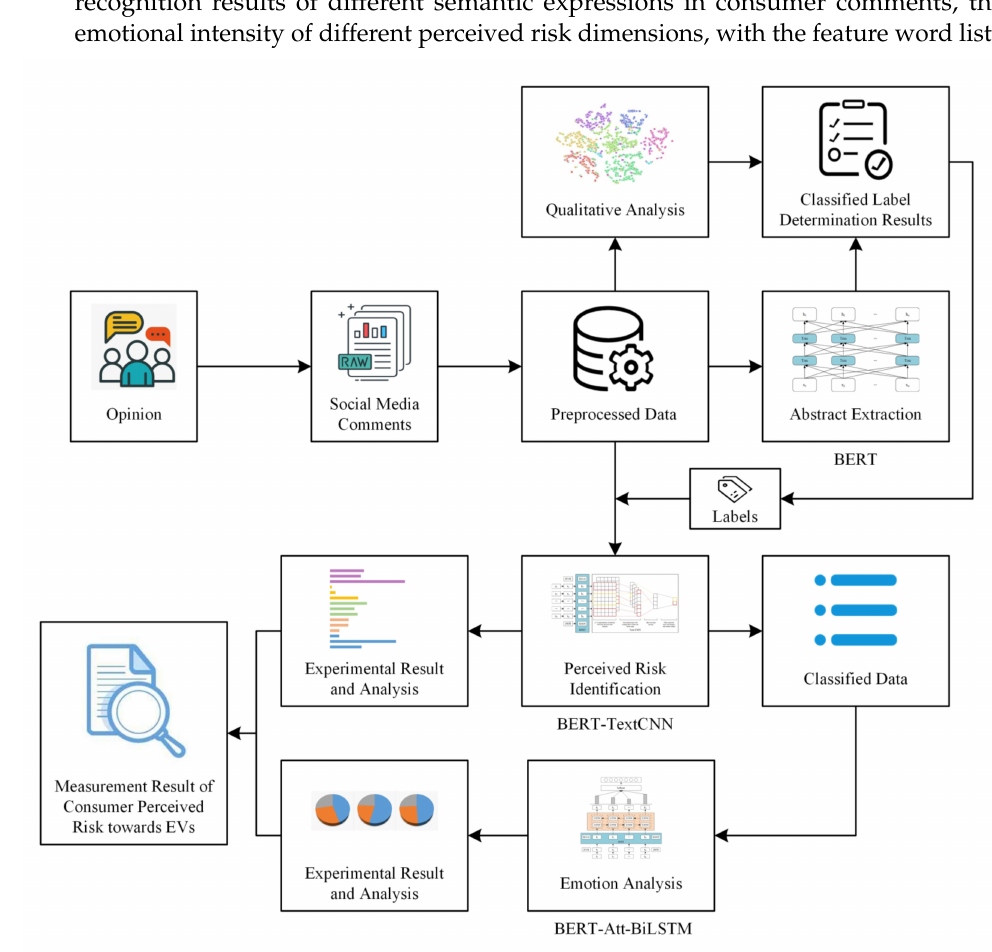
Figure 1. NLP Architecture of Customer Perceived Risk towards